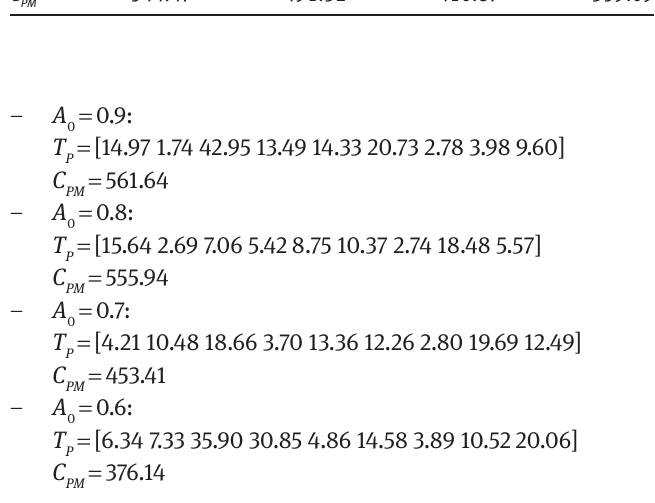
Table 4: PM Cost for Different Values of A